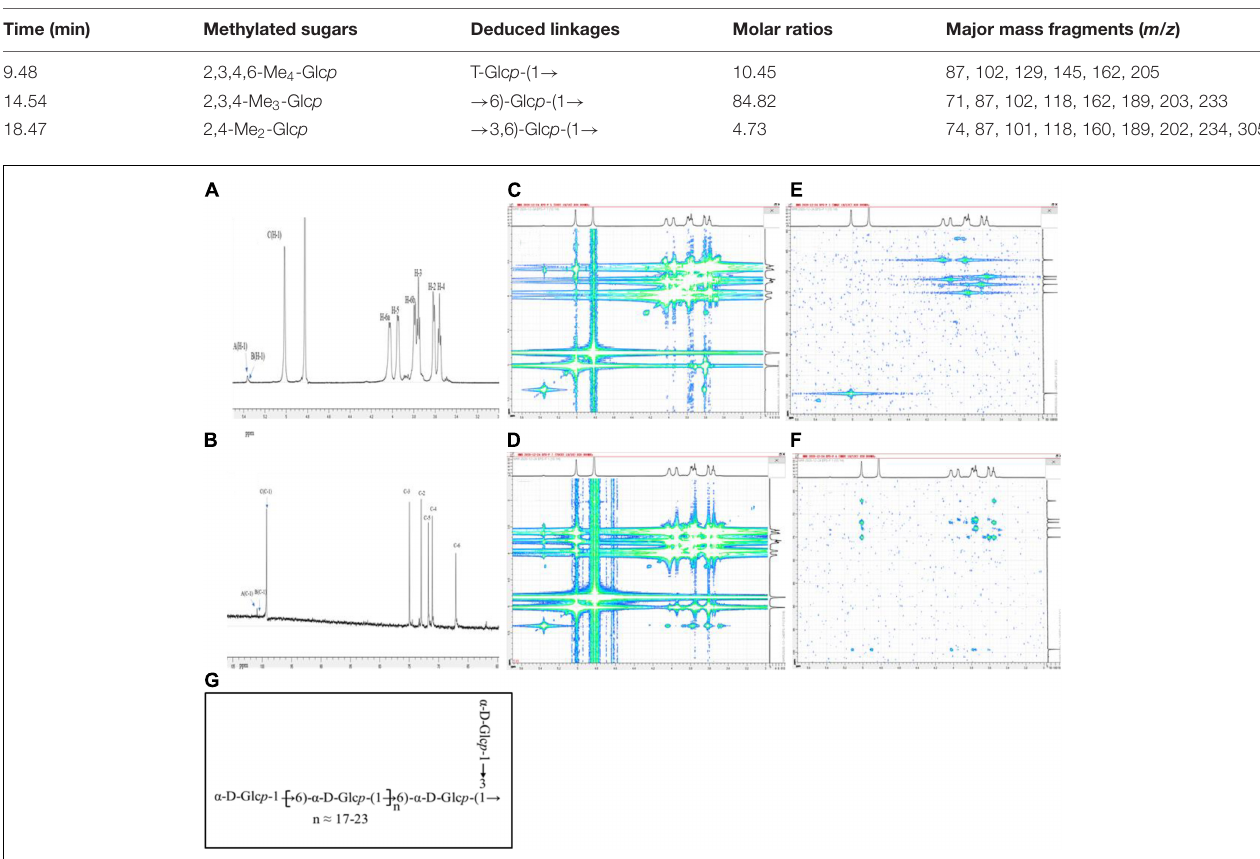
FIGURE 3 | NMR spectra of EPS-F2 recorded in D 2 O at 298 K: (A) 1D- 1 H spectrum and; (B) 1D- 13 C spectrum; (C) COSY spectrum; (D) TOCSY spectrum; (E) HSQC spectrum; (F) HMBC spectrum; (G) one putative structure of EPS-F2.